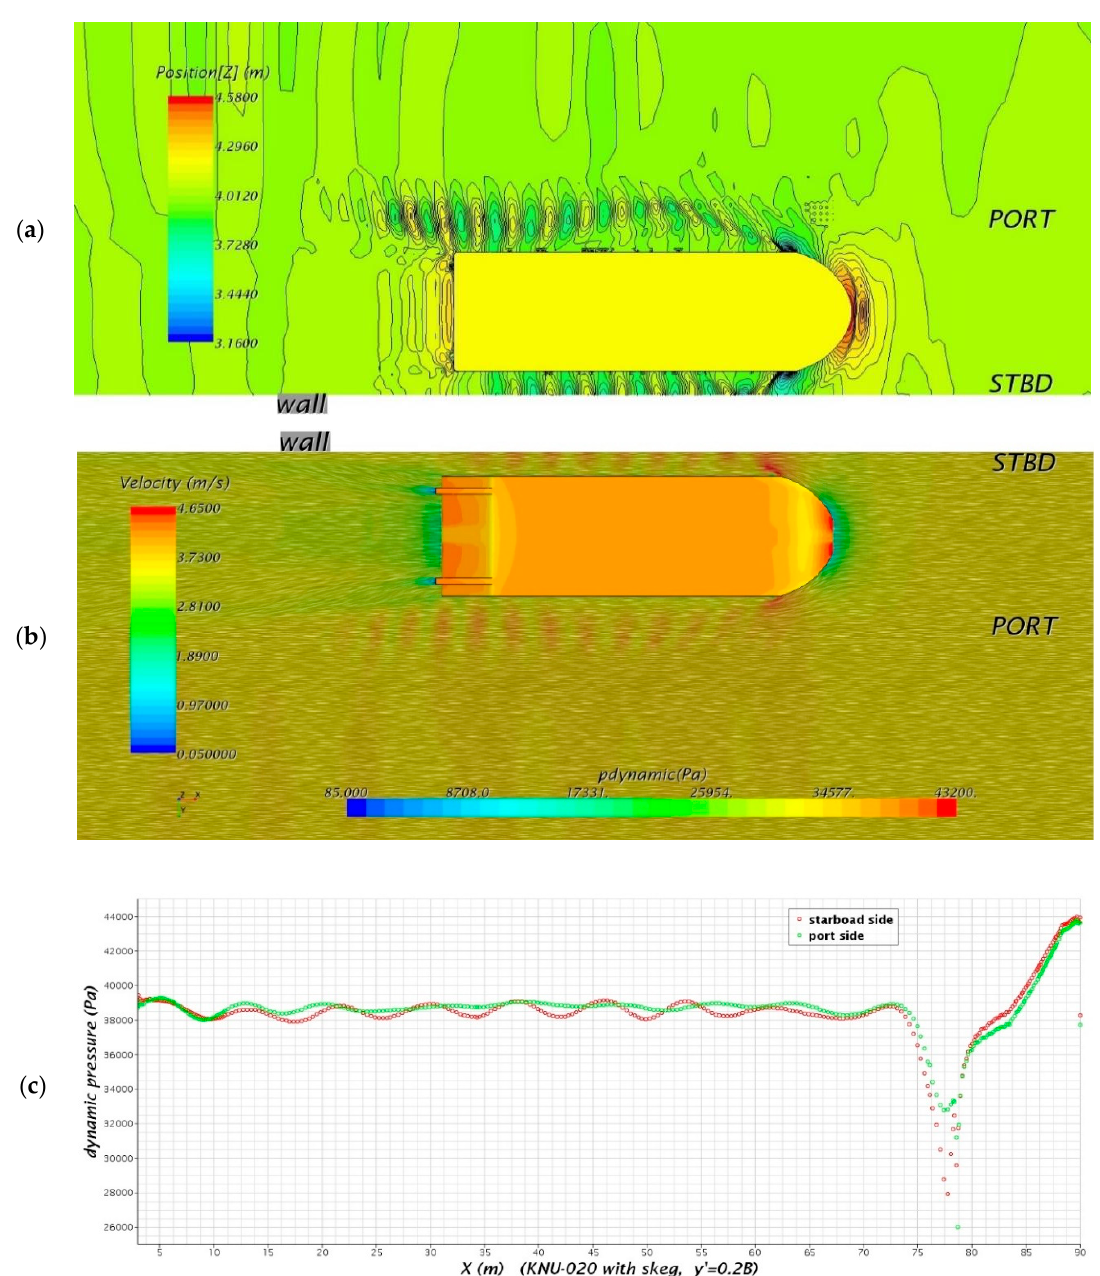
Figure 6. Simulation results for KNU-020 at y ′ = 0.2 B : ( a ) wave pattern; ( b ) velocity field with line integral convolution and hydrodynamic pressure distribution on the bottom; and ( c ) hydrodynamic pressure on the starboard and port side.